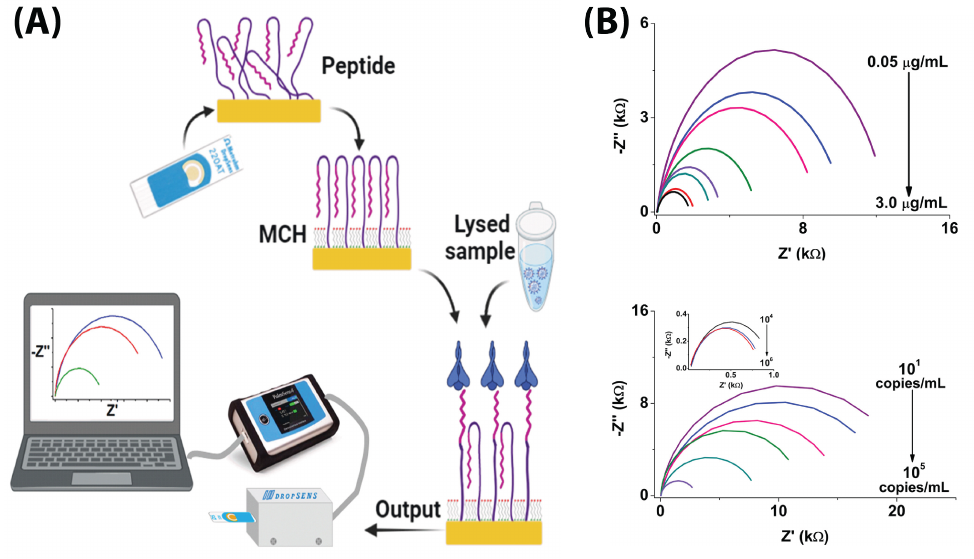
Figure 10. ( A ) The fabrication process of Soto and Orozco. They used an Au–Au–AgCl commercial screen-printed electrode from Dropsens and modified them with capture peptides [61]. ( B ) The sensor demonstrated a negative response, where increasing concentrations of S protein and lysed viral particles decreases the impedance signal. Reprinted with permission from Elsevier